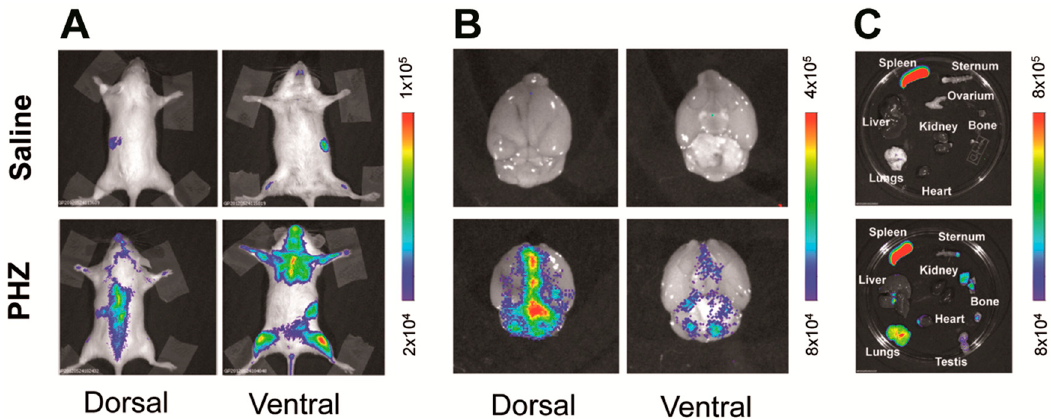
Figure 2. Phenylhydrazine administration modulates bioluminescence in vivo and ex vivo in MITO-Luc mice. MITO-Luc mice receiving intra peritoneal administration of saline solution (saline) or phenylhydrazine (PHZ) 75 mg/kg for two consecutive days were analyzed by in vivo and ex vivo bioluminescence imaging (BLI) 3 days after the last PHZ administration. In particular, the figure shows in vivo BLI analysis of a representative animal from the control (top) and PHZ (bottom) treated groups ( n = 3) ( A ); ex vivo BLI analysis of brains ( B ) and other organs ( C ) dissected from the same animals after necropsy. The color bars represent bioluminescent signals in radiance (photons/s/cm 2 /sr) from the lowest (blue) to the highest (red).